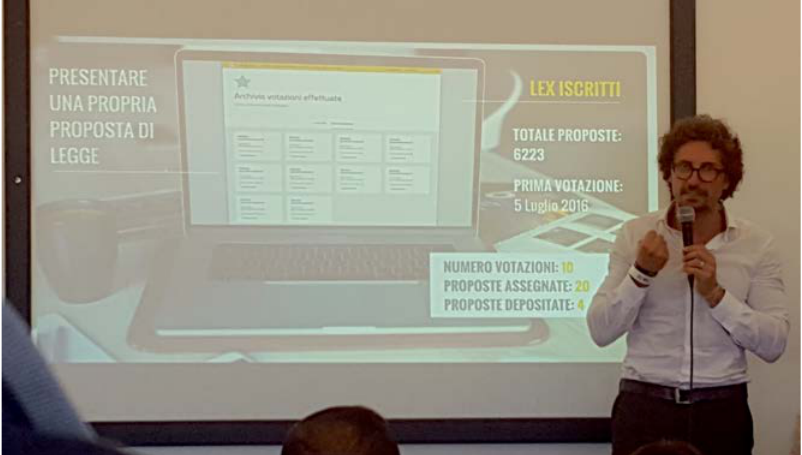
Figure 4: Danilo Toninelli presents Lex Members [Lex Iscritti], Rimini, September 23, 2017 (photo: Marco Deseriis